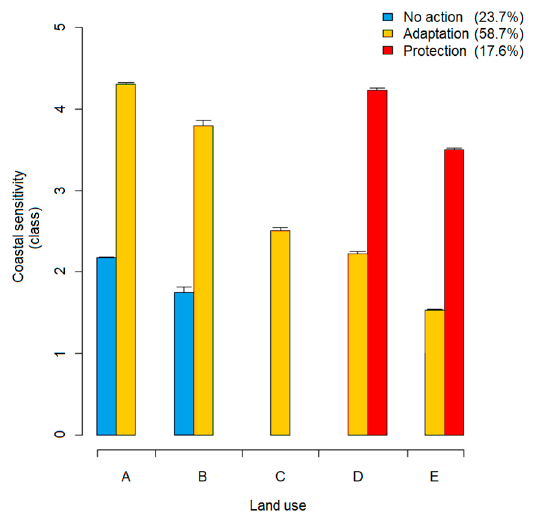
Figure 7. Response strategies resulting from the combination of coastal sensitivity and land use classes. Error bars are also presented. Percentages indicate the total amount of coastline classified within each response option.